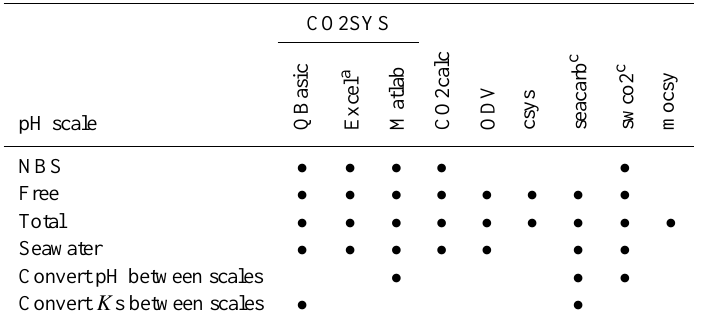
Table 5. Available pH scales for each package.